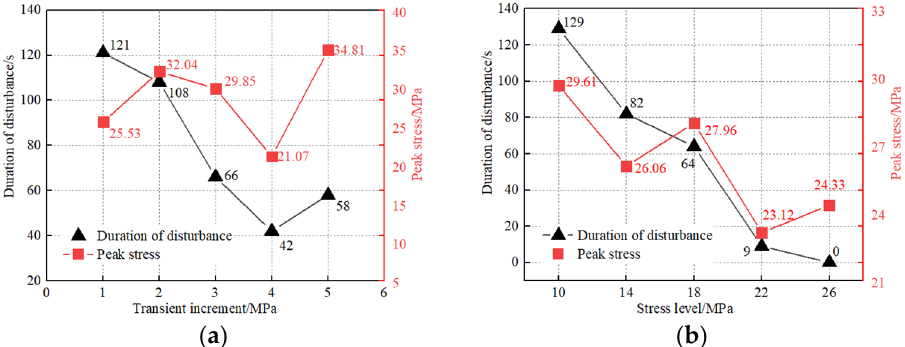
Figure 8. Relationship of control variables and transient stress parameters: ( a ) transient increment; ( b ) stress level.